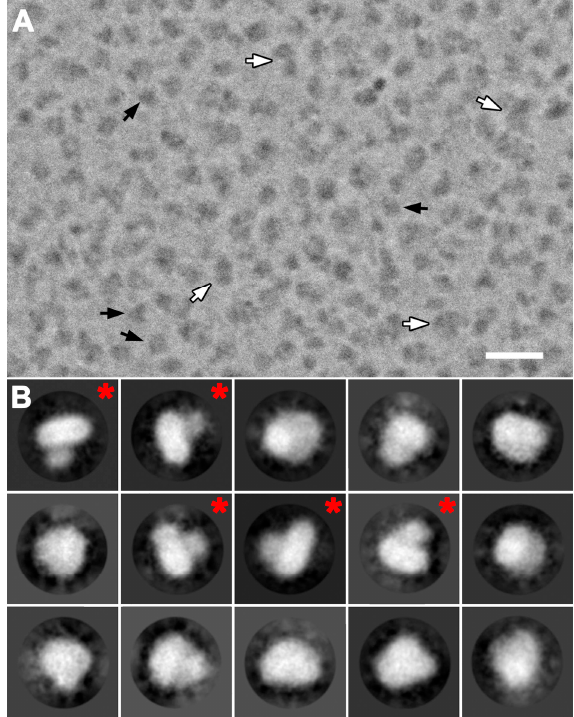
Figure 2. Cryo-electron microscopy (cryo-EM) of purified 4F2hc-LAT2 and gallery of 2D-class averages. ( A ) Displayed is a representative cryo-EM image collected using the Volta phase plate (VPP). Two sets of particles with different lengths are discerned. Smaller particles are in a size range of 100–120 Å (black arrows) and significantly more abundant than larger particles (size range of 180–200 Å, white arrows). ( B ) A gallery of 15 representative 2D-class averages is displayed and ordered according to decreasing number of particles assigned to each class. 2D-class averages labeled with a red asterisk reflect projections as viewed from the membrane plane indicating two differently sized densities. Protein density is black and white in panels ( A ) and ( B ), respectively. The scale bar in ( A ) is 300 Å and the frame size in ( B ) 227 Å.